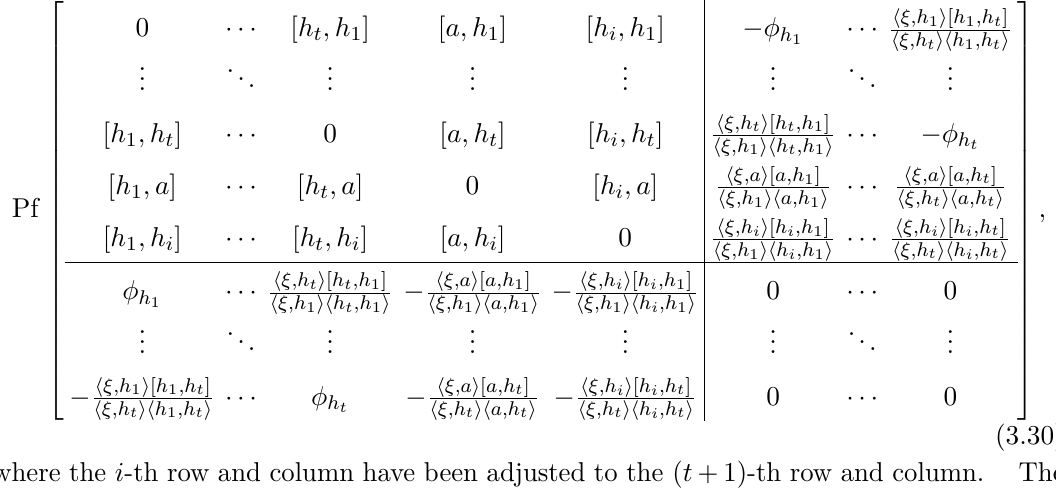
) , (b): gluons a and b are connected, and (c): h i ) i , b